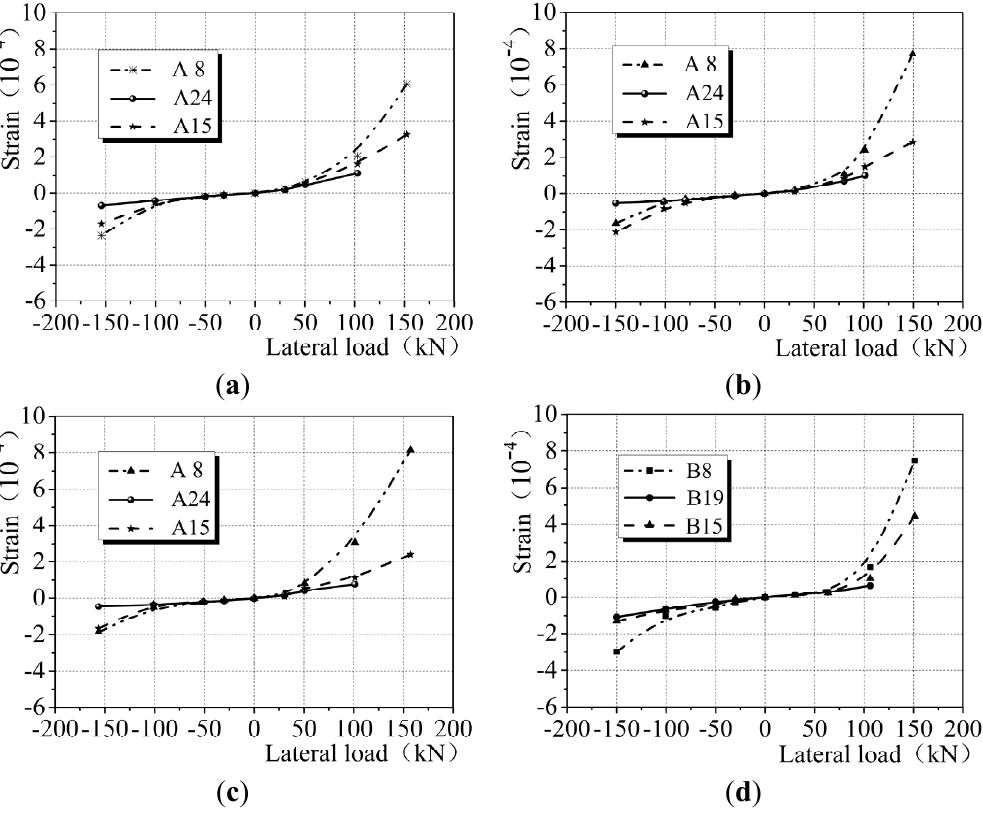
Figure 15. Lateral force-material strain diagram for CEW/CIW. ( a ) E-1; ( b ) E-2; ( c ) E-3; ( d )